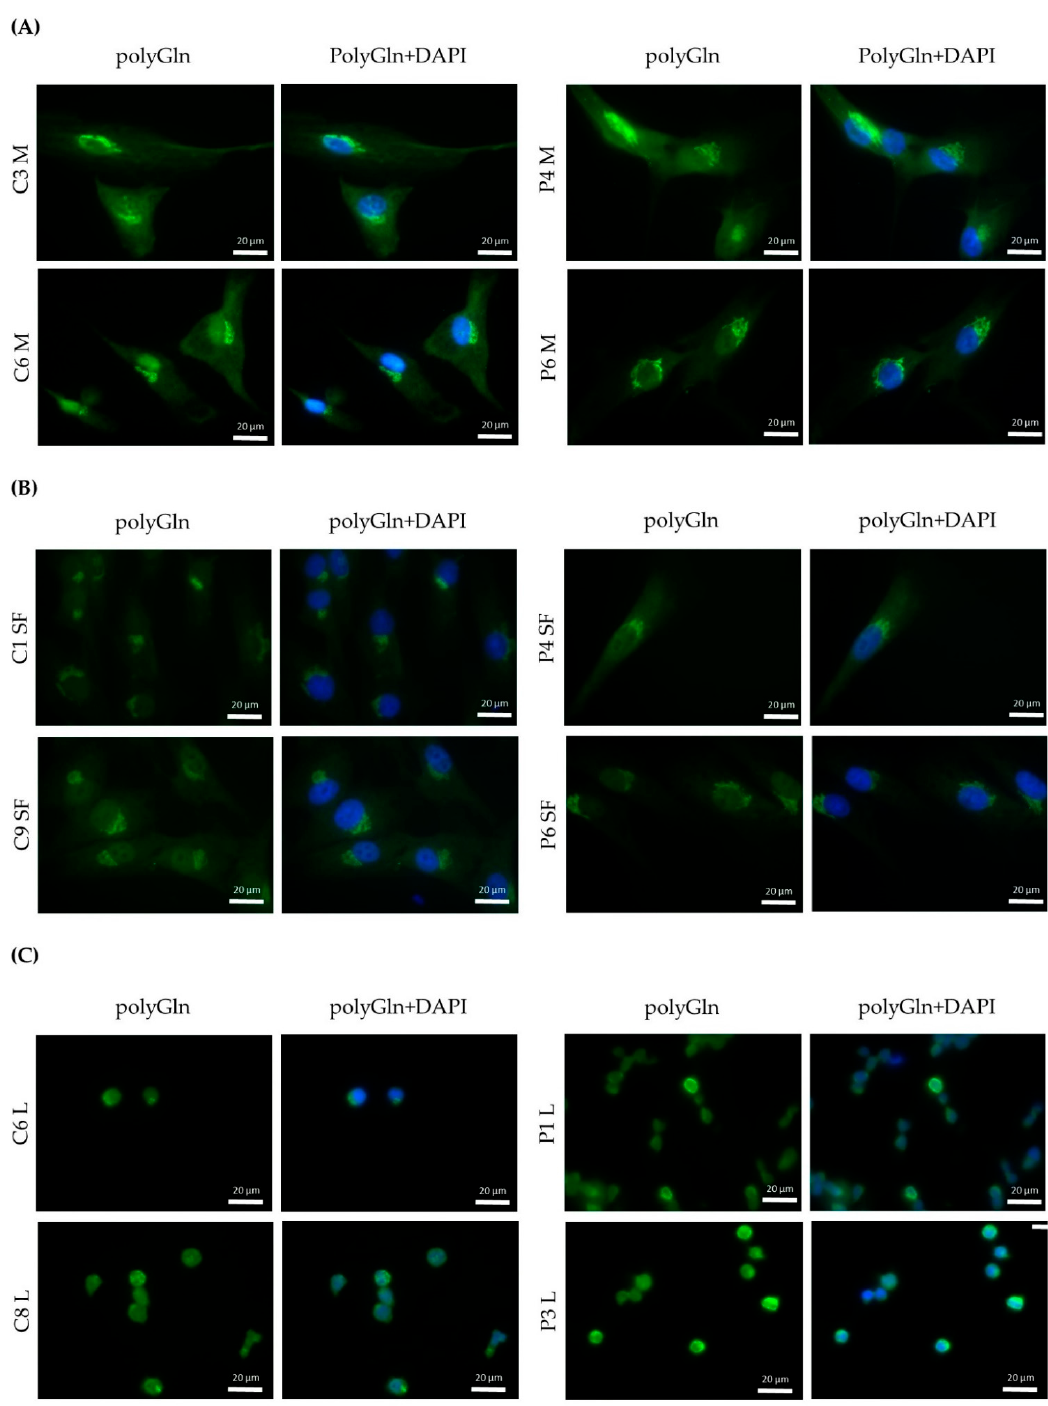
Figure 4. Qualitative analysis of polyGln RAN proteins in all DM1 cells. ( A ) Immunofluorescence polyGln staining with #1874 (alexa fluor-488, green) of human control and DM1 myoblasts. Nuclei indicated by DAPI (blue) (C: n = 5, P: n = 6) ( B ) Immunofluorescence polyGln staining with #1874 (alexa fluor-488, green) of human control and DM1 skin fibroblasts. Nuclei indicated by DAPI (blue) (C: n = 5, P: n = 8). ( C ) Immunofluorescence polyGln staining with #1874 (alexa fluor-488, green) of human control and DM1 lymphoblastoids (C: n = 4, P: n = 5). Nuclei indicated by DAPI (blue). Abbreviations: C = control; P = DM1 patient; polyGln = polyglutamine; M = myoblasts; SF = skin fibroblasts; L =